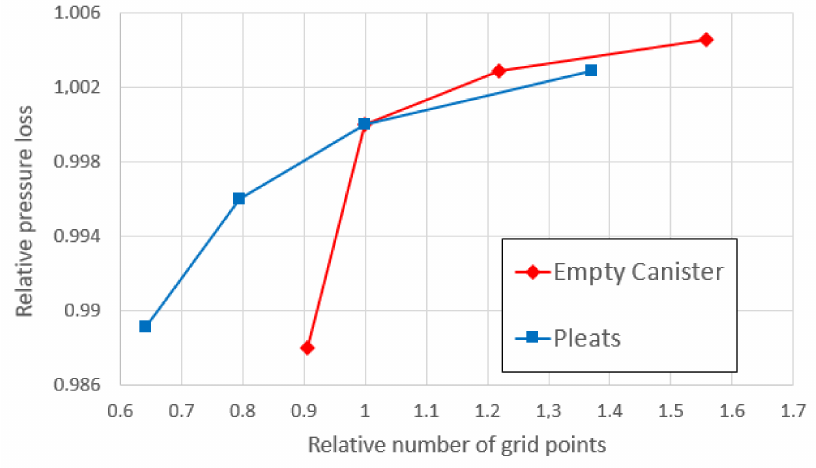
Figure 24. Relative pressure loss in pleats and empty canister based on relative number of grid